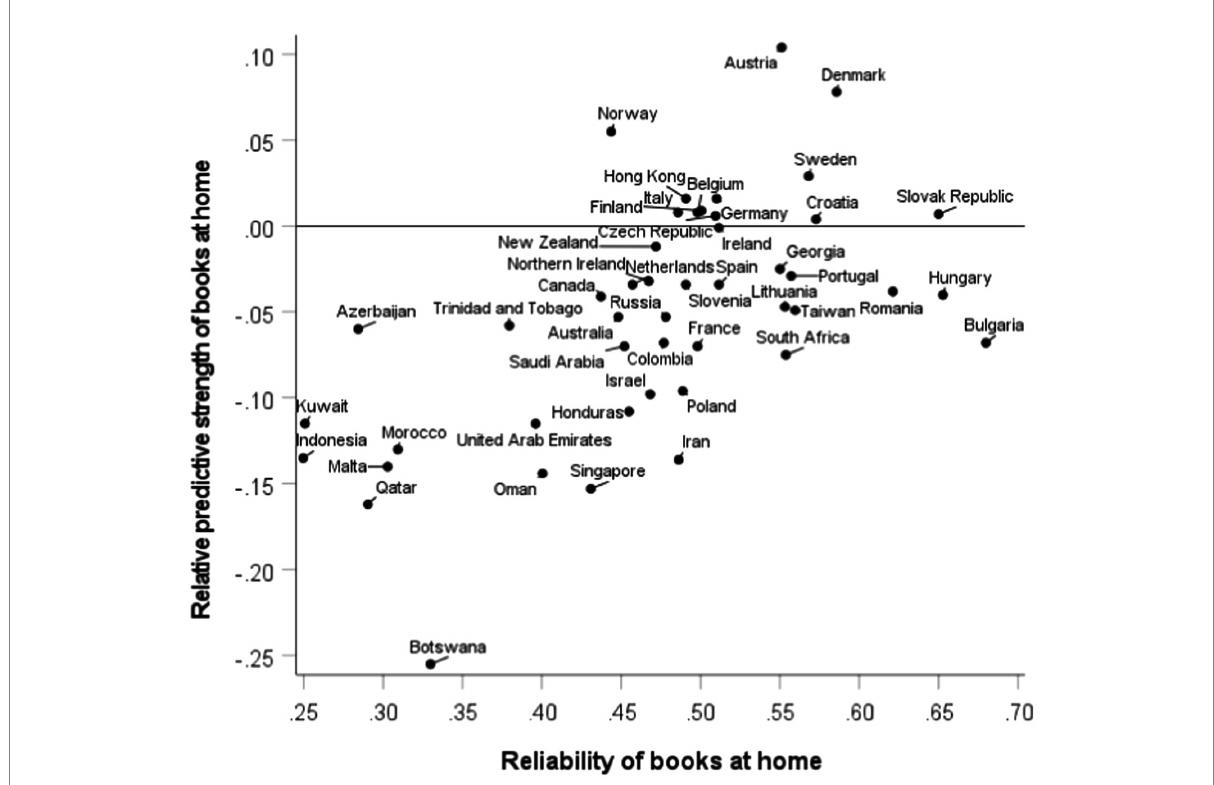
FIGURE 3 Country variation in the reliability of books at home data (x-axis) and the relative predictive strength of books at home (y-axis), operationalized as the difference between the literacy-books at home correlation and the literacy-parents’ education correlation. Above the reference line at zero are 12 countries where student literacy was better predicted by books at home than by parent’s